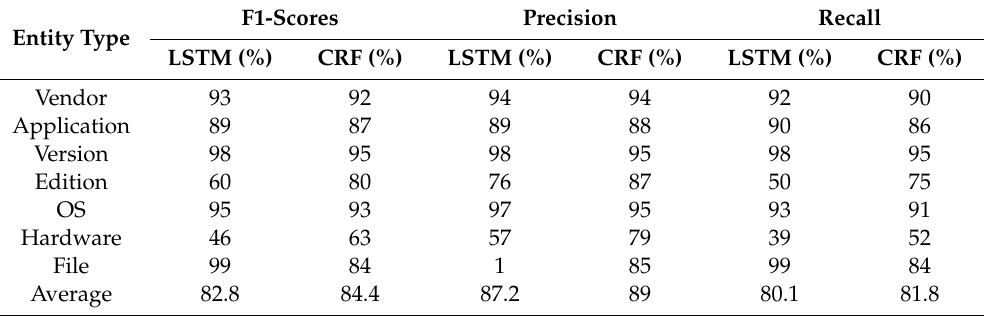
Table 5. Precision, recall, and F1 scores of CRF and LSTM-CRF for seven entity tags.